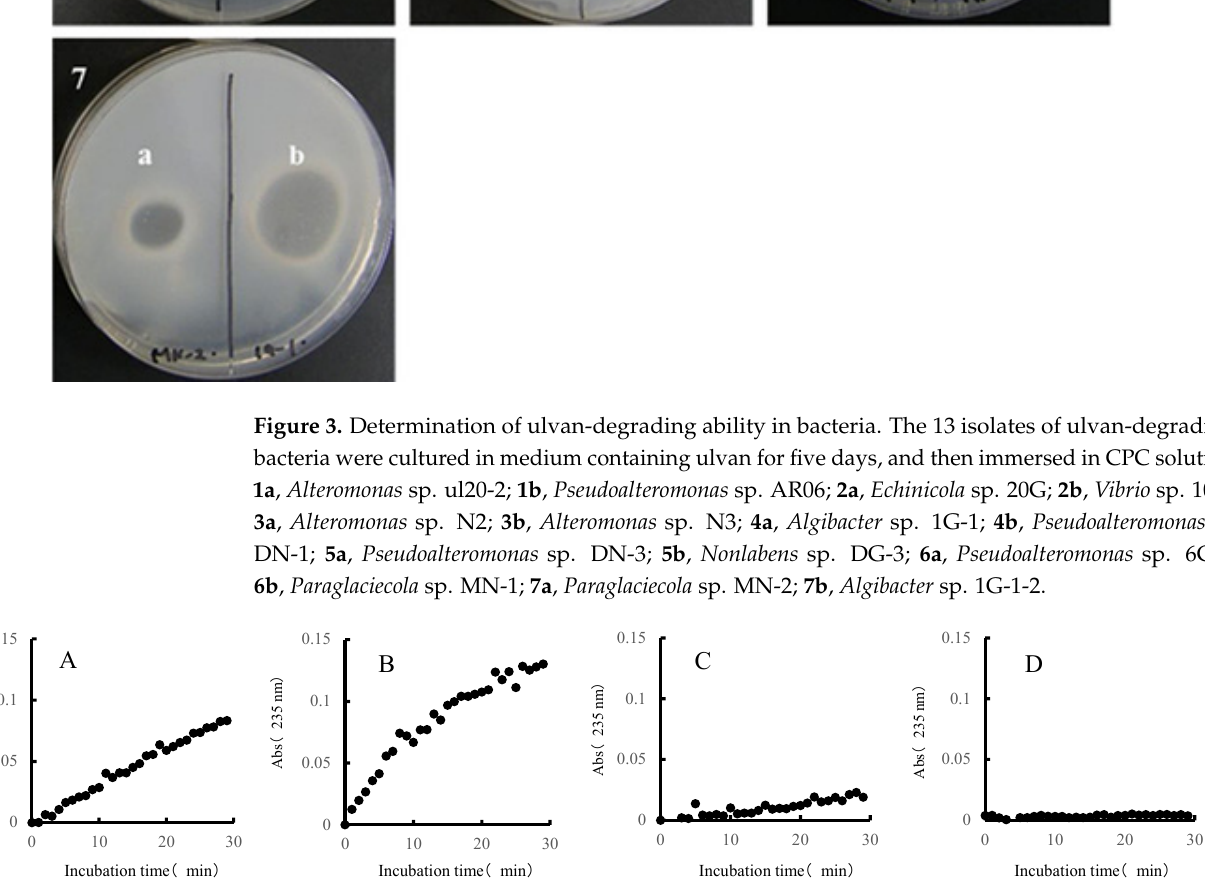
Figure 4. Reaction time course (235 nm) of ulvan and extracellular concentrates (( A ), Alteromonas sp. ul20-2; ( B ), Vibrio sp. 10N; ( C ), Echinicola sp. 20G; ( D ), negative control).